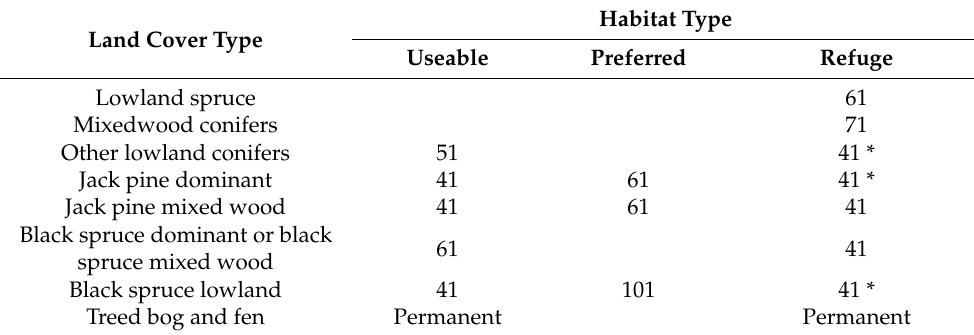
Table 3. Minimum age (years) at which a stand attains suitable caribou habitat